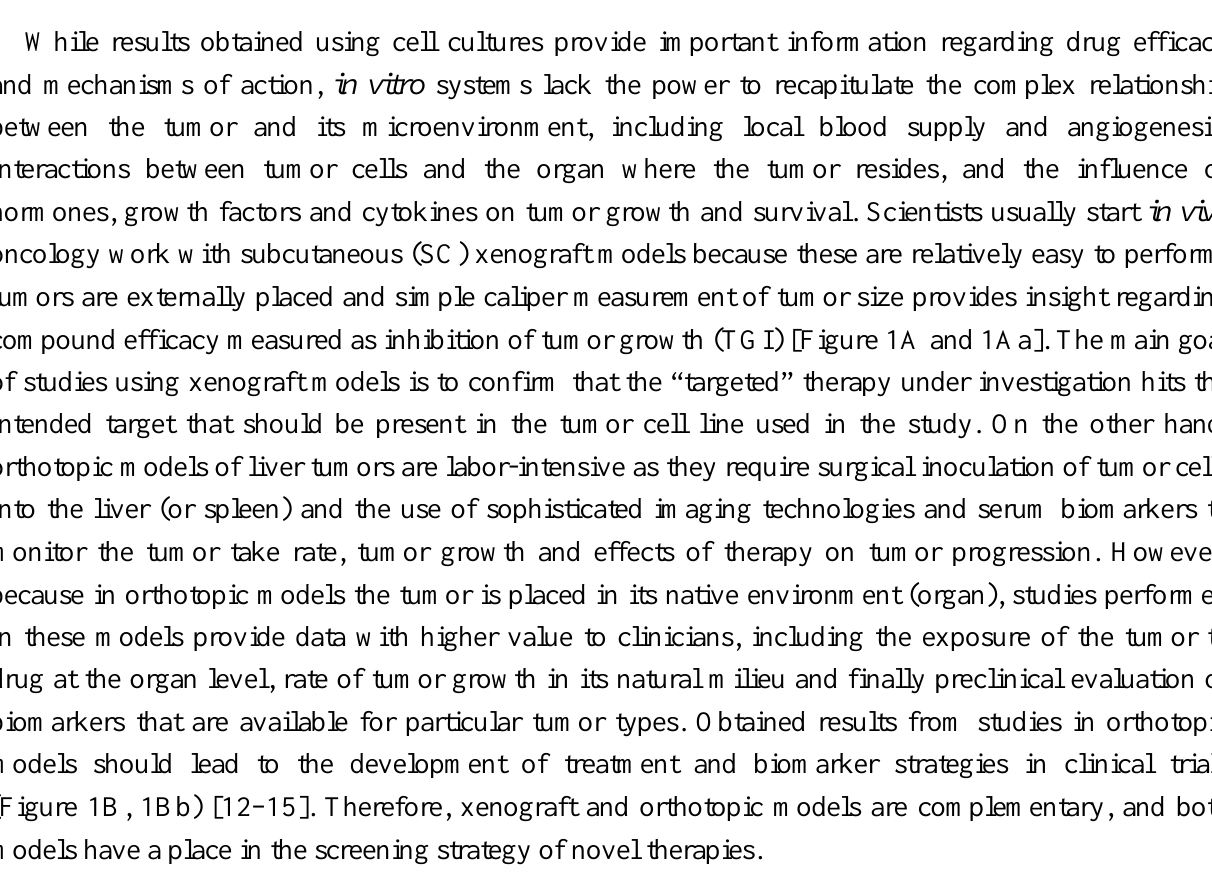
Figure 1. Xenografts of HCC tumors in nude rats measured by caliper ( A ) and the appearance of a highly vascularized subcutaneous tumor ( Aa ). Inoculation of HCC cells into the livers of nude rats to create the orthotopic model ( B ). Inoculation of HCC cells into the liver results in restriction of the tumor mass to the liver lobe in which the tumor cells were injected ( Bb , arrow indicates tumor mass). Bioluminescent imaging of the orthotopic tumor ( C ) using IVIS technology is a helpful method to confirm the tumor take rate, monitor tumor progression and assess therapeutic